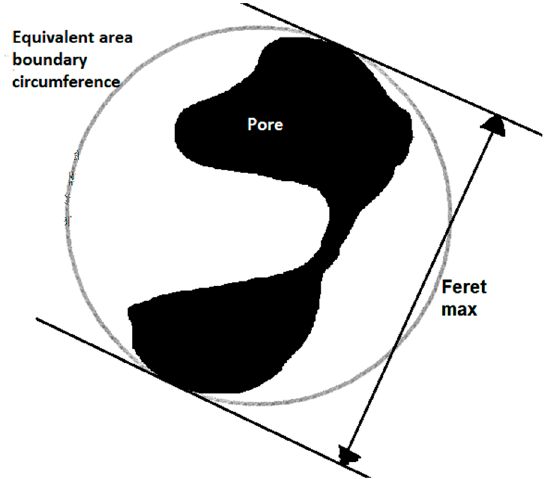
Figure 11. Sketch illustrating the procedure for evaluating the characteristic dimensions of the pore, defined by the maximum Feret diameter. Image taken from